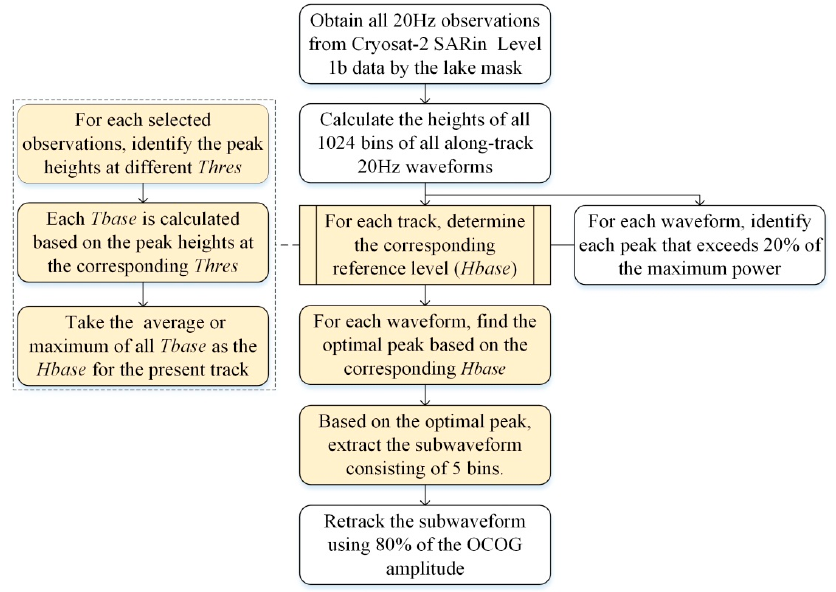
Figure 4. Flowchart describing the Improved Multiple Waveform Persistent Peak Retracker (ImpMWaPP). Steps with yellow background are different from the MWaPP retracker.